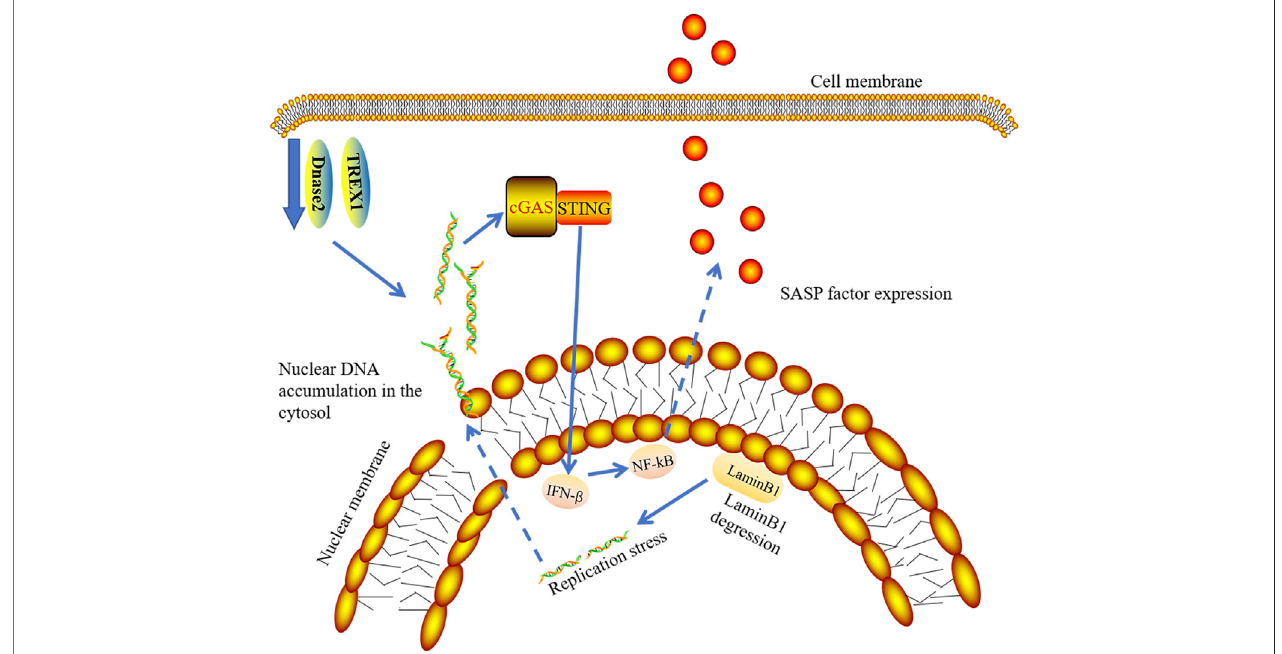
FIGURE 6 | cGAS-STING signaling pathway and senescence. In senescent cells, degraded LaminB1 leads to nuclear membrane damage and chromatin fragments leaking into cytoplasm, which induces the release of SASP by activation of cGAS-STING-IFN pathway. TREX1 and Dnase2 enzymes are down-regulated in senescent cells, contributing to the accumulation of nuclear DNA in